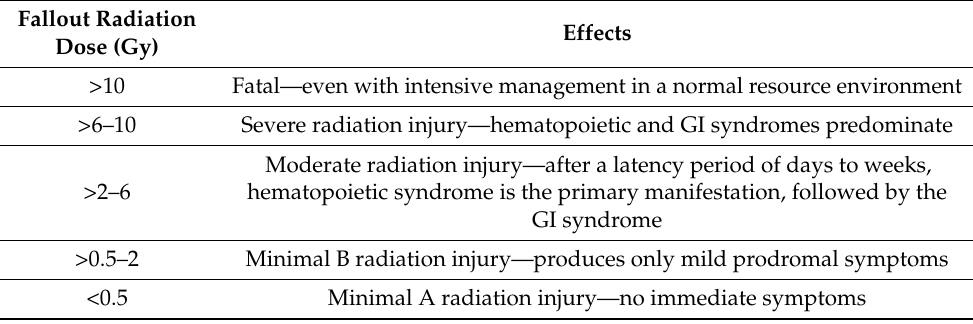
Table 3. Fallout radiation categories and associated